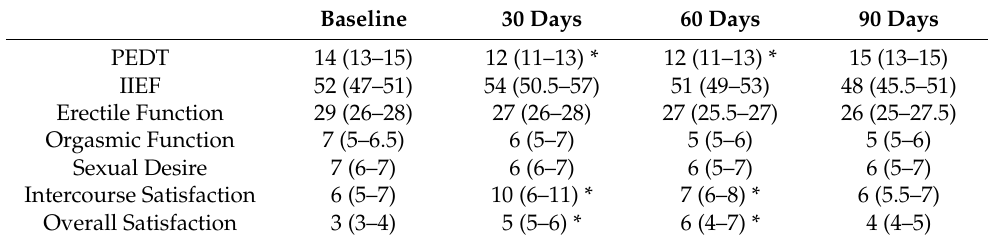
Table 3. Score of PEDT and IIEF questionnaires at different study protocol times. * < 0.001 vs.